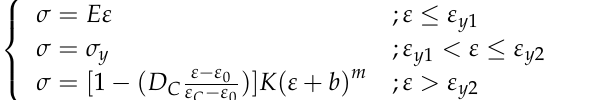
( b ) Figure 10. Hysteresis curves under different stress-strain constitutive relations. ( a ) Bilinear model; ( b ) Basic requirements of the hysteresis model.